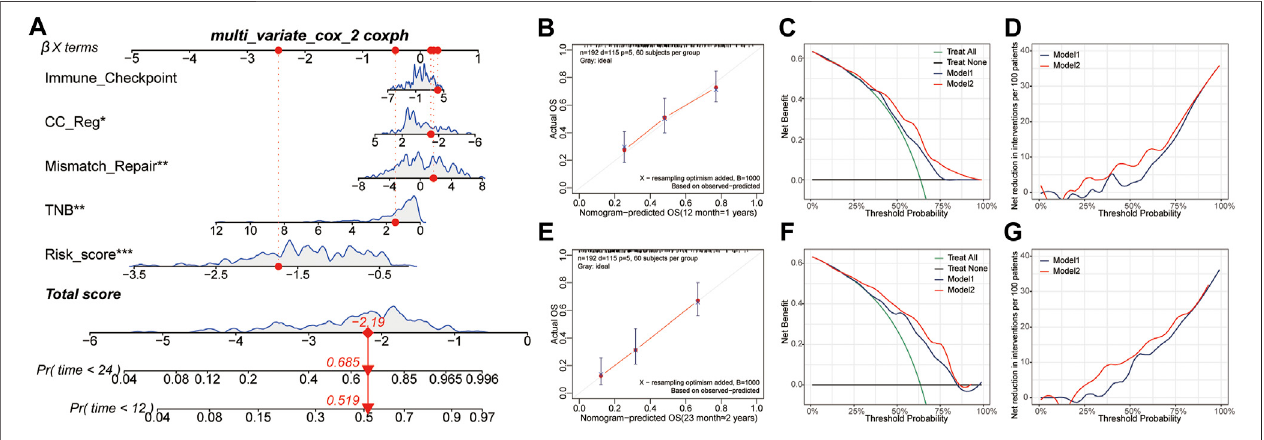
FIGURE 7 | Construction and validation of survival risk model after immunotherapy. (A) , The Nomogram is composed of risk score and signature score of core biological function. (B,E) ,Calibrationcurvesofpatients ’ 1-yearand2-yearsurvivalafterimmunotherapybasedonthetotalscoremodel. (C,D,F,G) ,Thedecisioncurveandnetbene fi tcurve of patients ’ survival at 1 and 2 years after immunotherapy, according to different models. CC reg, cell cycle regulation; TNB, tumor neoantigen burden.